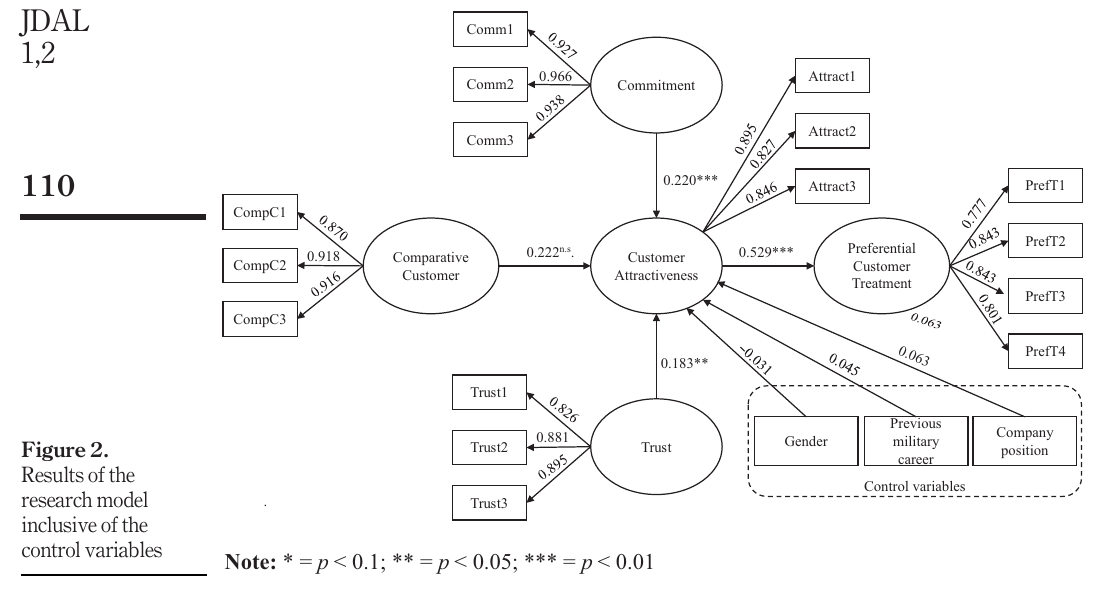
Table IV. Results of the coef fi cient of determination and predictive relevance